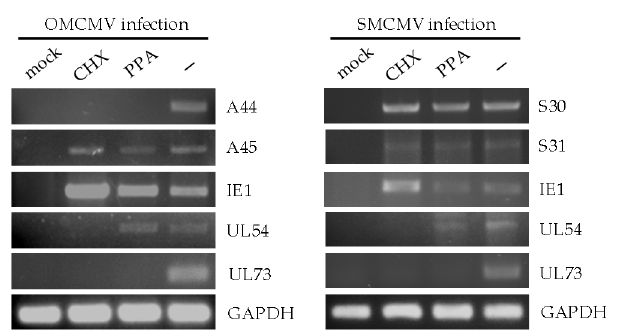
Figure 2. Expression of vCD48s during OMCMV and SMCMV infections. Owl monkey kidney (OMK) cells (left panels) or HEL299 (right panels) cells were mock infected or infected with OMCMV or SMCMV at an moi of 1 in the absence (-) or presence of cycloheximide (CHX) or phosphonoacetic acid (PPA), as indicated in the Materials and Methods. Whole-cell RNAs were harvested at 13 hpi in the case of CHX samples and at 72 hpi for the rest of the samples, and subsequently reverse transcribed. PCRs were performed using primer sets specific for OMCMV genes A44 , A45 , IE1 , UL54 , and UL73 , SMCMV genes S30 , S31 , IE1 , UL54 , and UL73 , or GAPDH , as shown. Amplified products were separated on 1% agarose gels and visualized by RedSafe nucleic acid staining solution.